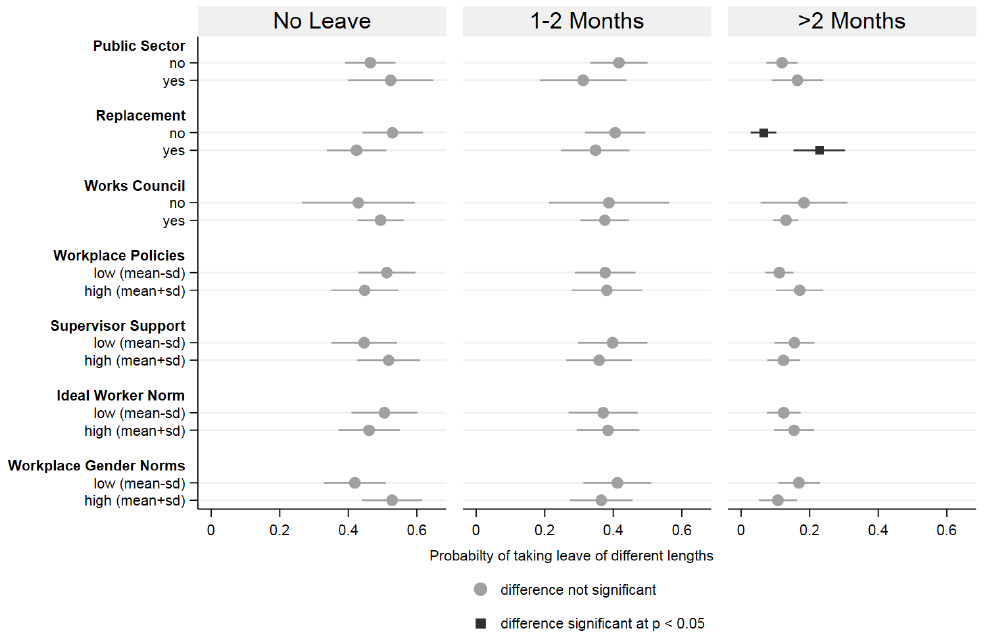
Figure 3. Predicted margins of the fathers’ likelihood of taking different lengths of leave with 95% confidence intervals. Note: N = 369. The results are based on models that are adjusted for the following covariates: age, marital status, tertiary education, partner’s tertiary education, number of children, birth year of the youngest child (as a proxy for time since the introduction of reform), region, professional position, fixed-term contract; full results available in Table A5 in the Appendix A.